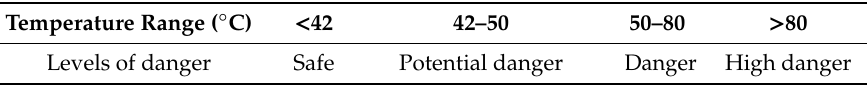
Table 2. Fire temperature parameter range.